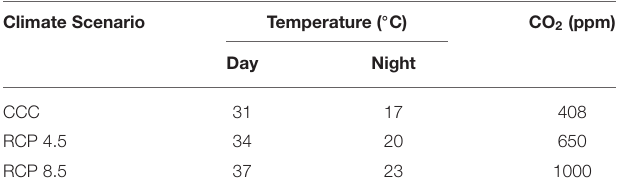
TABLE 1 | Climatic conditions assessed for broccoli growth: CCC (current climate conditions), RCP 4.5, and RCP 8.5 (Representative Concentration Pathways 4.5 and 8.5) regionalized for Region of Murcia for years